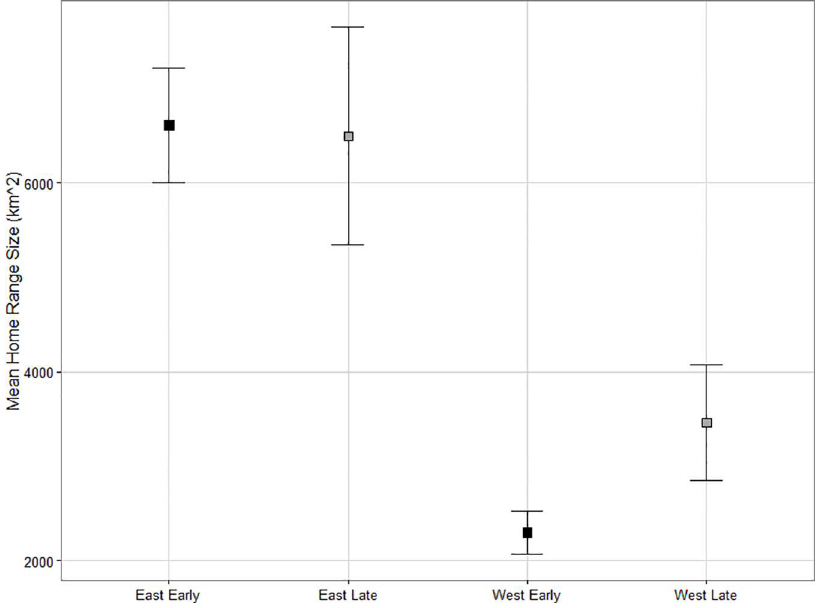
Fig 3. Mean caribou home range sizes between time periods and study areas. A comparisonof mean home range size for borealcaribou( Rangifertaranduscaribou )betweenthe eastern and western study areas in the early period (black; prior to wide spreadcaribou habitat management policy application, 1995–2001) and late period(grey; followinghabitat management policy application,2009–2013). Error bars represent standarderror.